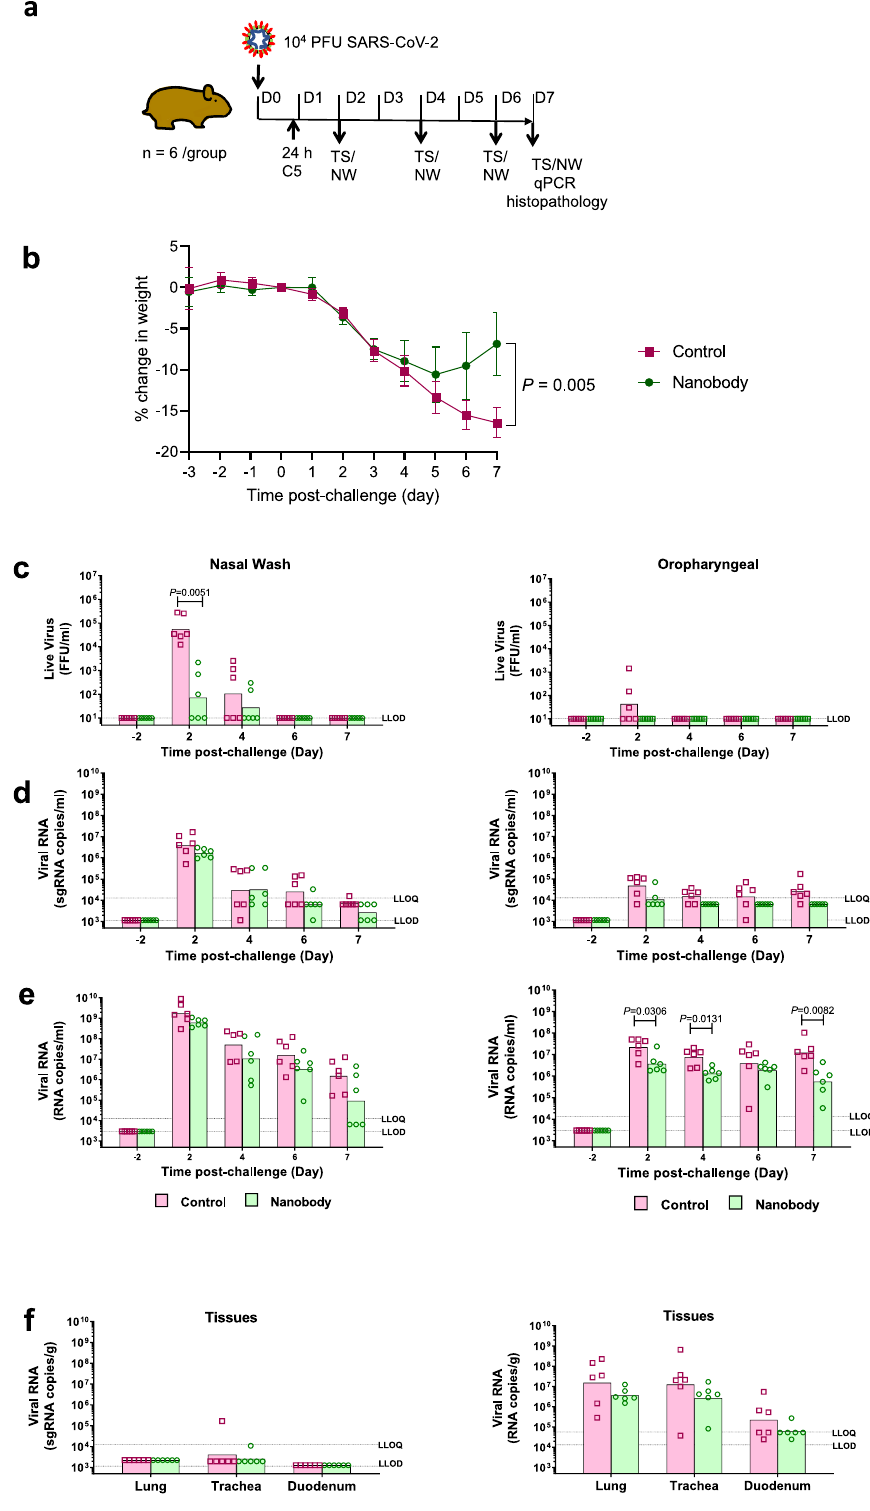
untreated group showed a signi fi cant and progressive weight loss (20% by day 7), whereas all animals treated therapeutically, 24 h after viral challenge, showed only a small weight loss and from day 2 had recovered to pre-challenged weights (Fig. 7b). The animals pre-treated 2 h before IN virus inoculation with 4 mg/kg C5 via the intranasal route showed no change in weight. The weight loss in all C5-treated groups was signi fi cantly different